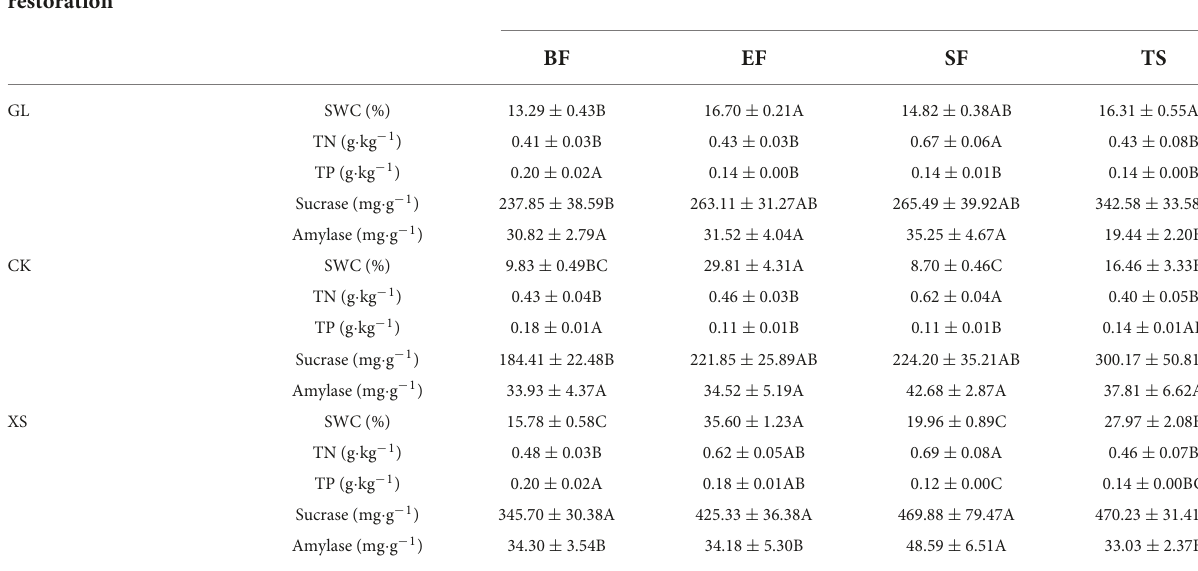
TABLE 4 Characteristics of changes in soil environmental factors in 0–40 cm under different vegetation restoration types during seasonal freeze-thaw